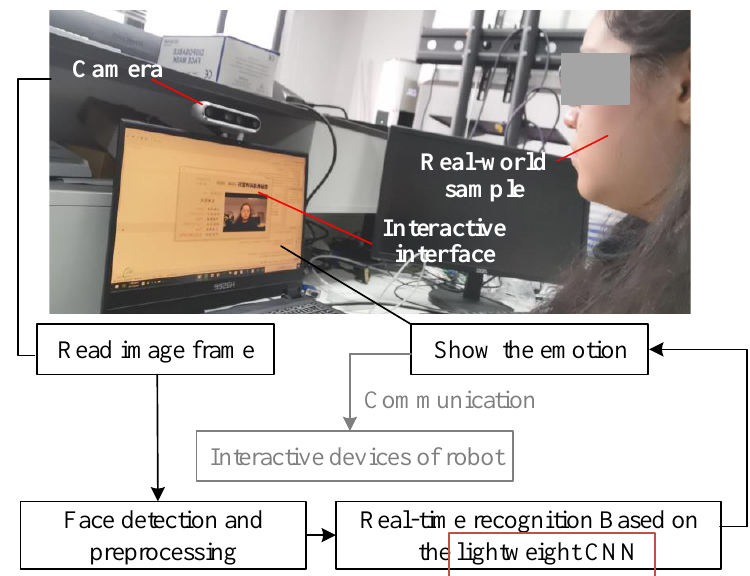
Figure 1. Block diagram of the